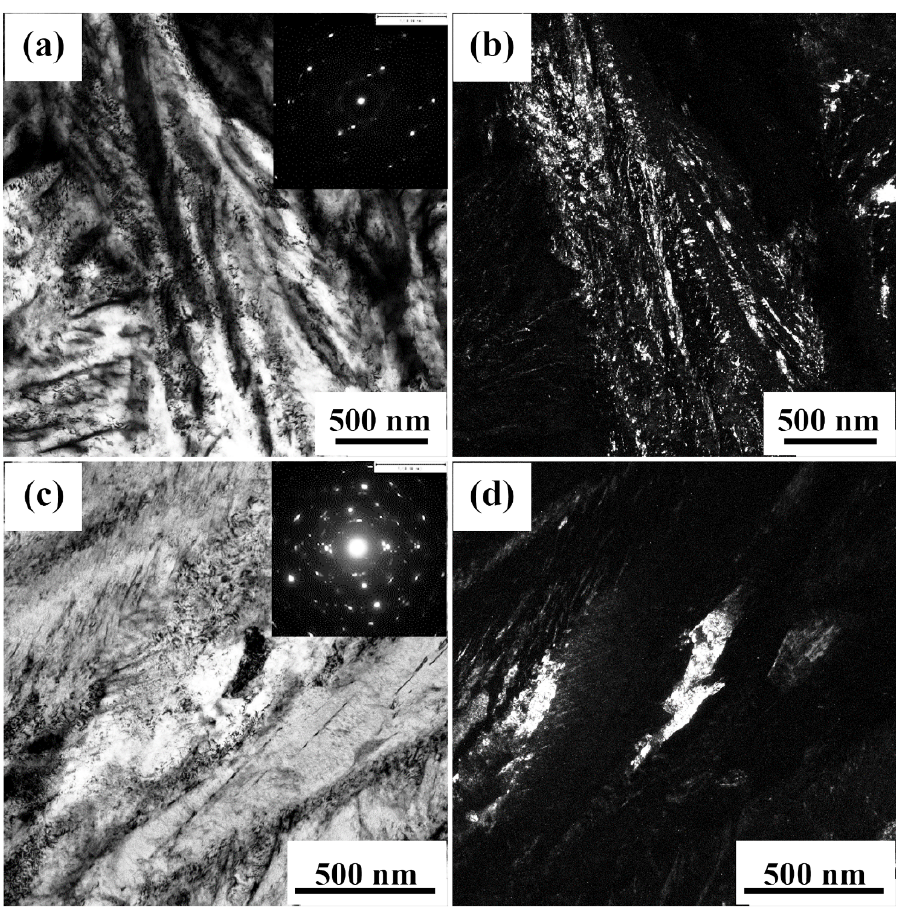
Figure 10. TEM images of specimens held at 350 °C ( a , b ) and 200 °C ( c , d )) for 1 h. The BF images with inset SAED patterns and the DF images from the diffraction spots are shown for RA phase detection.